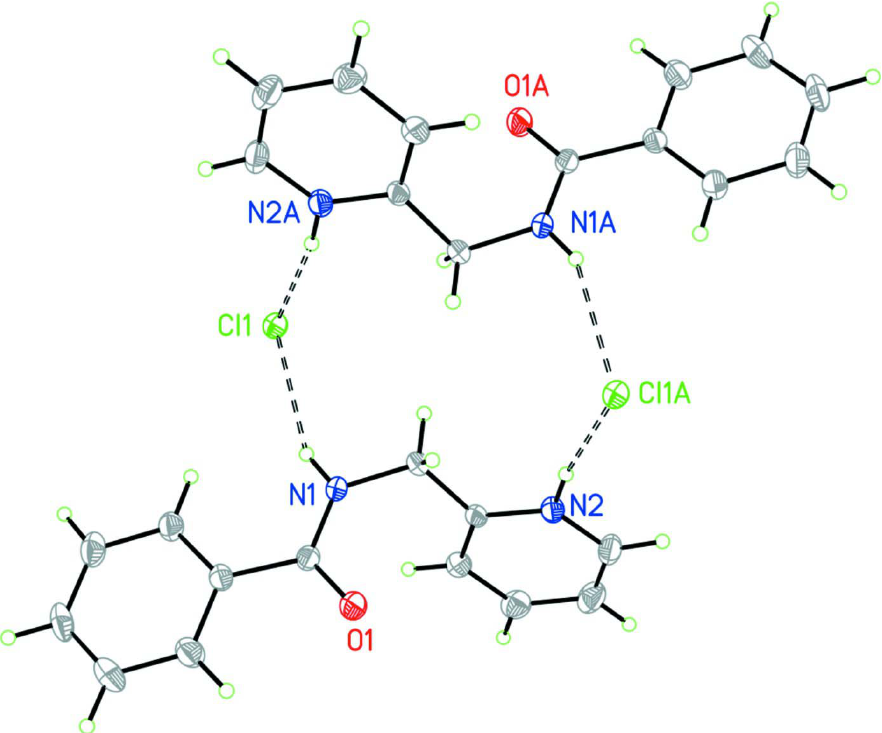
Figure 2 A view of the pseudo dimer formed by N-H···Cl hydrogen bonds shown as dashed lines. H atoms are represented as small spheres of arbitrary radii.[Symetry code: (A)1 - x, -y + 1,